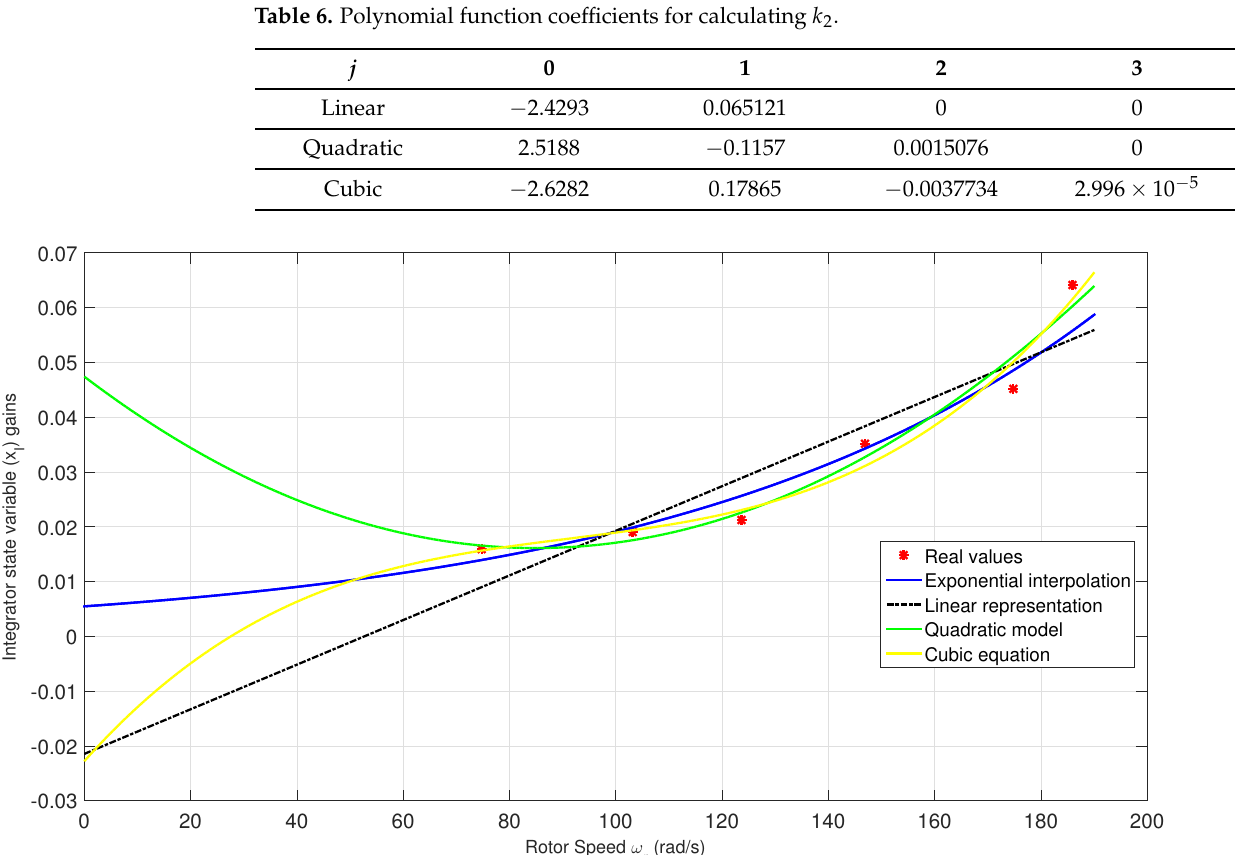
Figure 5. Graphics related to the functions for calculating the integrator state variable